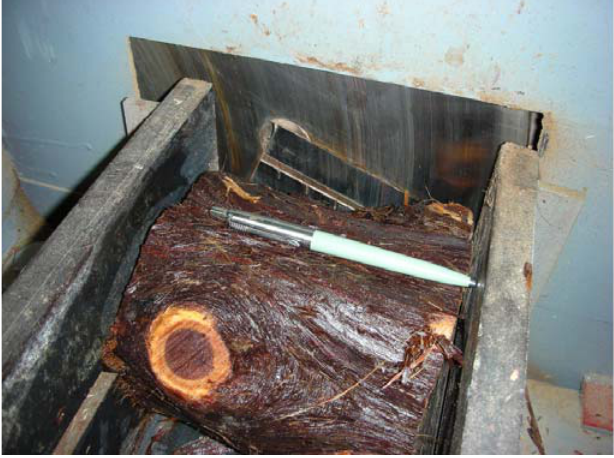
Figure 1. Strand generating process (courtesy of Forest Products Laboratory, Louisiana State University, Baton Rouge, LA, USA).